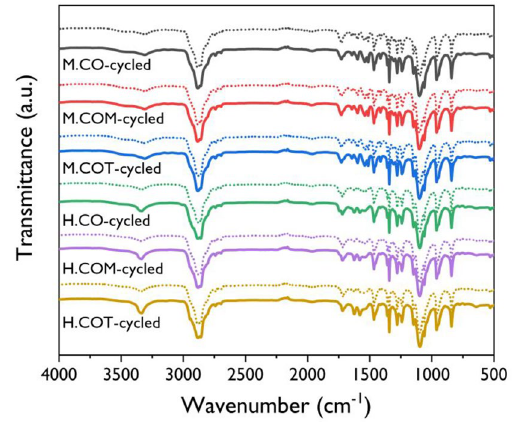
Figure 7. FT-IR spectra of the SSPCMs before (dot line) and after (solid line) the accelerated thermal cycling